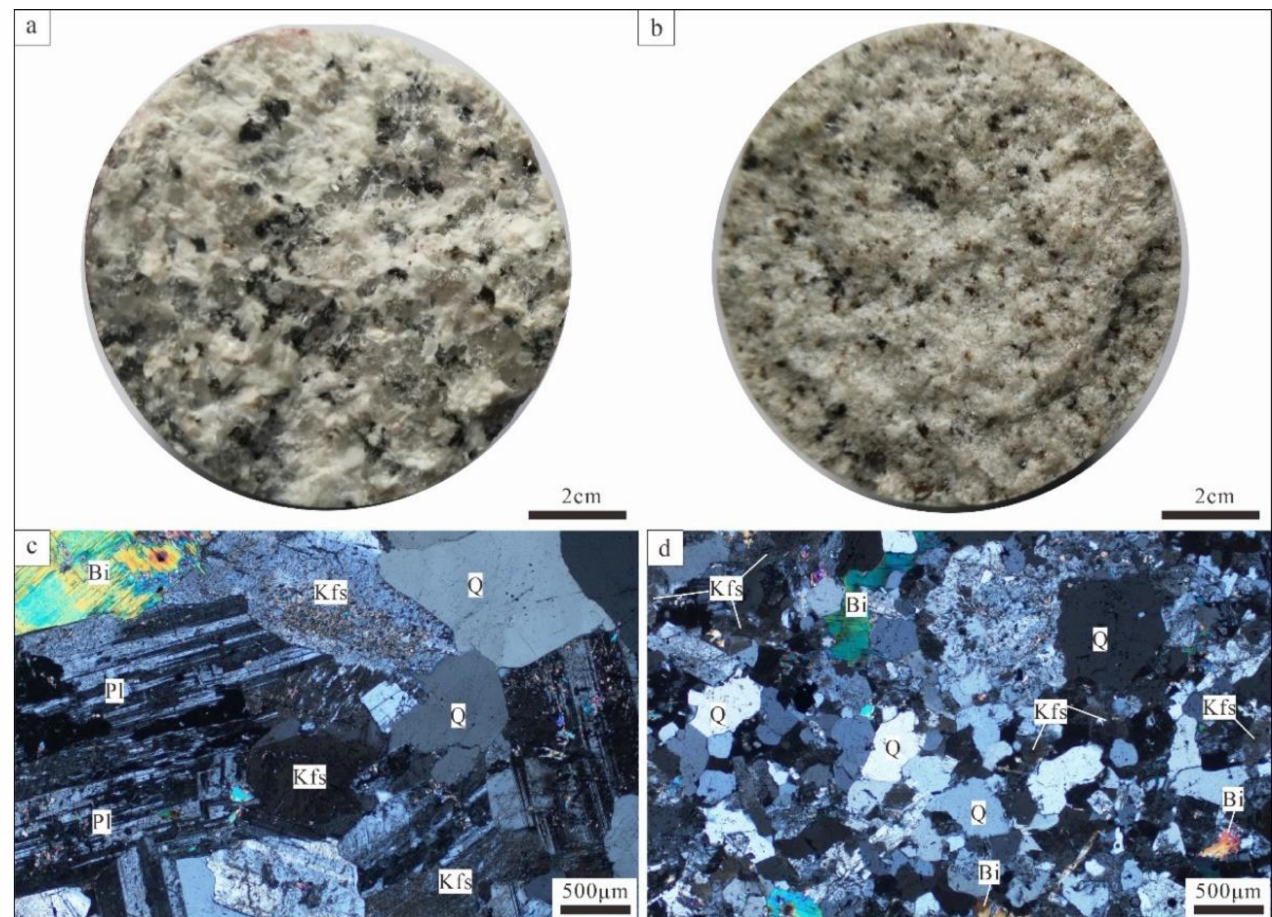
Figure 3. Hand specimens ( a , b ) and microscope ( c , d ) photographs of LG. Bi: biotite; Kfs: K-feldspar; Pl: plagioclase; Q: